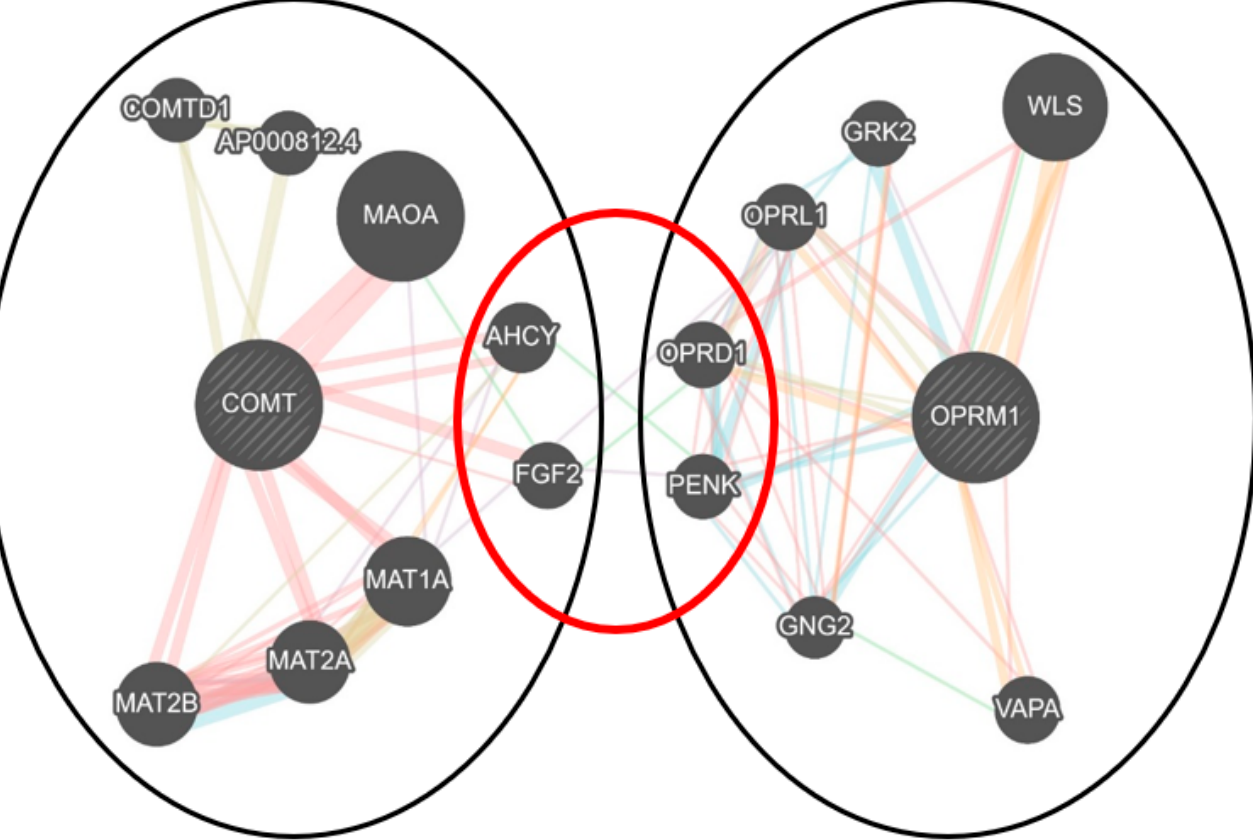
Figure 5. GeneMANIA network and gene–gene interaction analysis for the COMT and OPRM1 genes. Venn diagram depicting the shared network pathways and secondary gene-associated networks that indirectly associates COMT and OPRM1 . Indicated by color is physical interactions (pink), genetic interactions (dark green), co-localization (dark blue), co-expressed (purple), predicted (orange), pathway (light blue) and shared protein domain (light green) network for 15 genes.